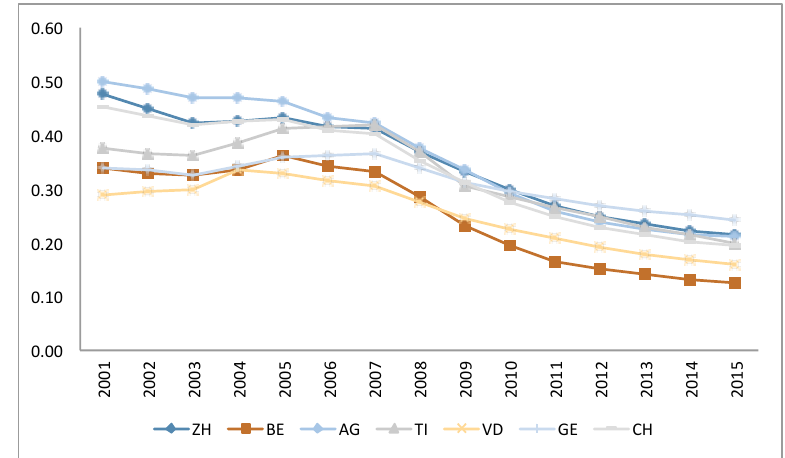
Figure 4. Share of the population aged 26 years or more.